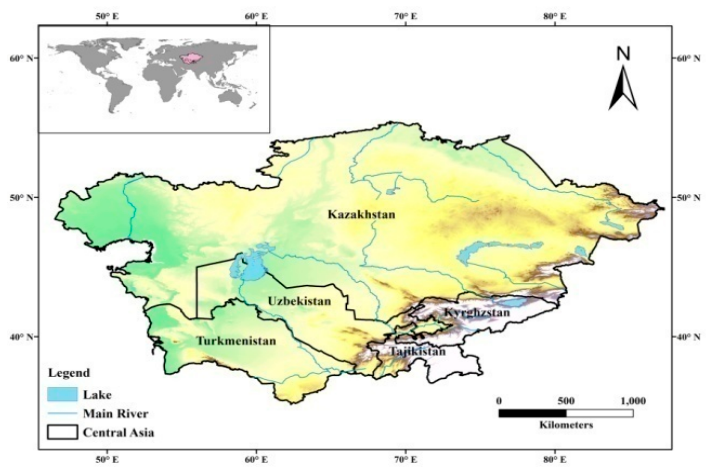
Figure 1. The geographical location and borders of the five countries.